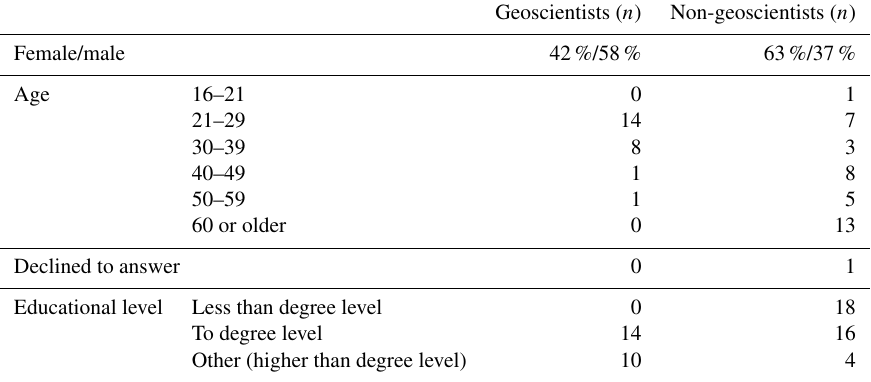
Table 1. Socio-demographic details across all study